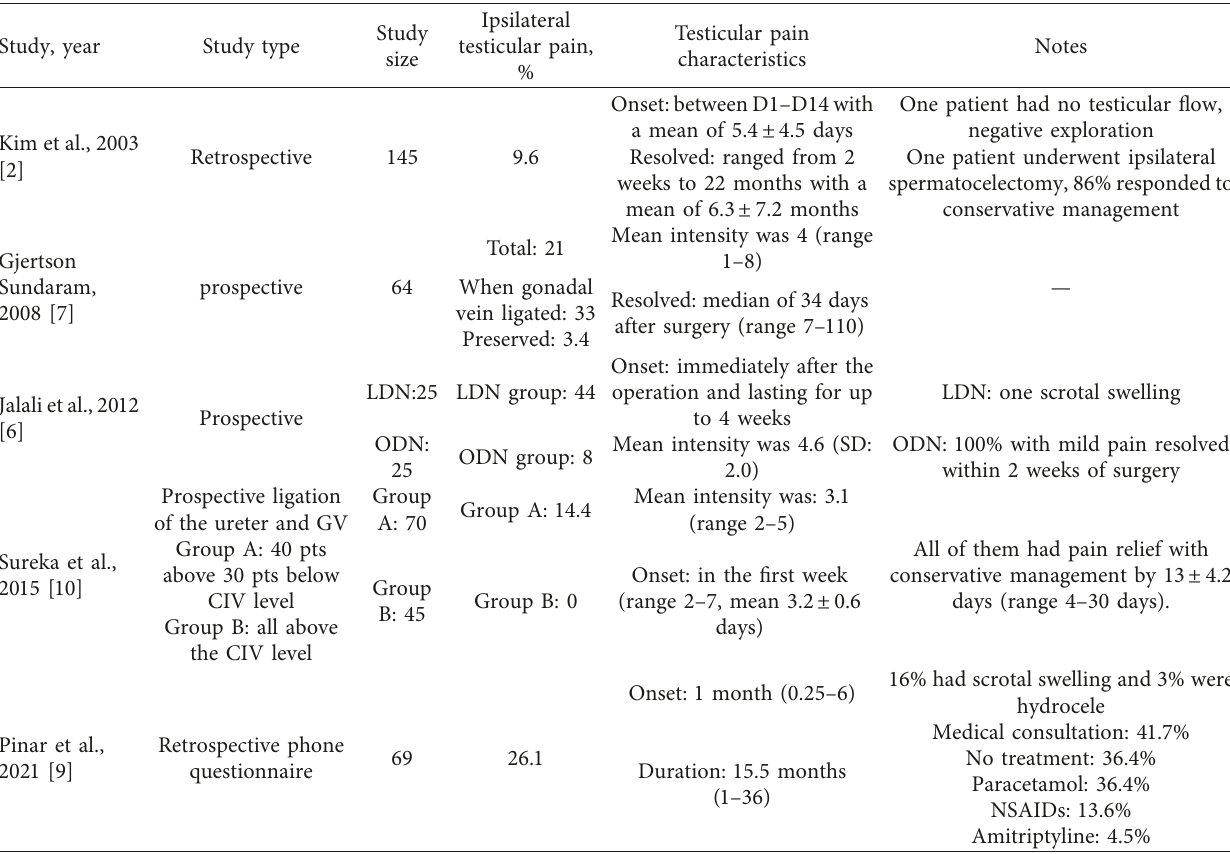
Table 3: Summary of studies of postlaparoscopic donor nephrectomy testicular